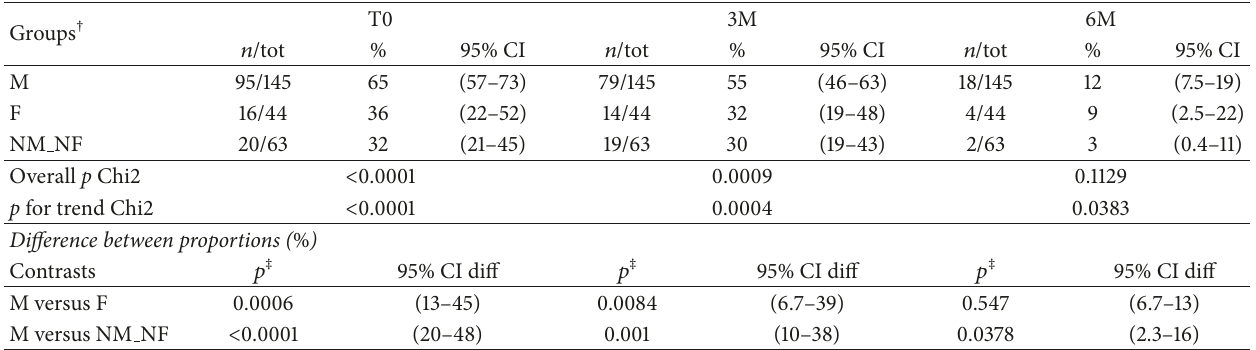
Table 2: Complete statistical analysis.